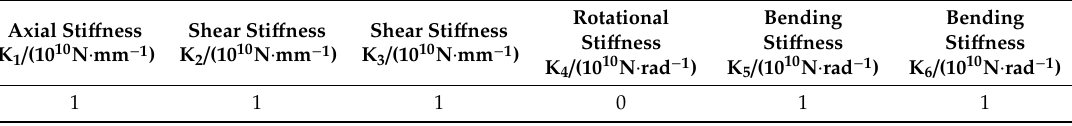
Figure 12. Schematic of the finite element model of shear test set-up. Table 2. Stiffness parameters of CBUSH bolt.